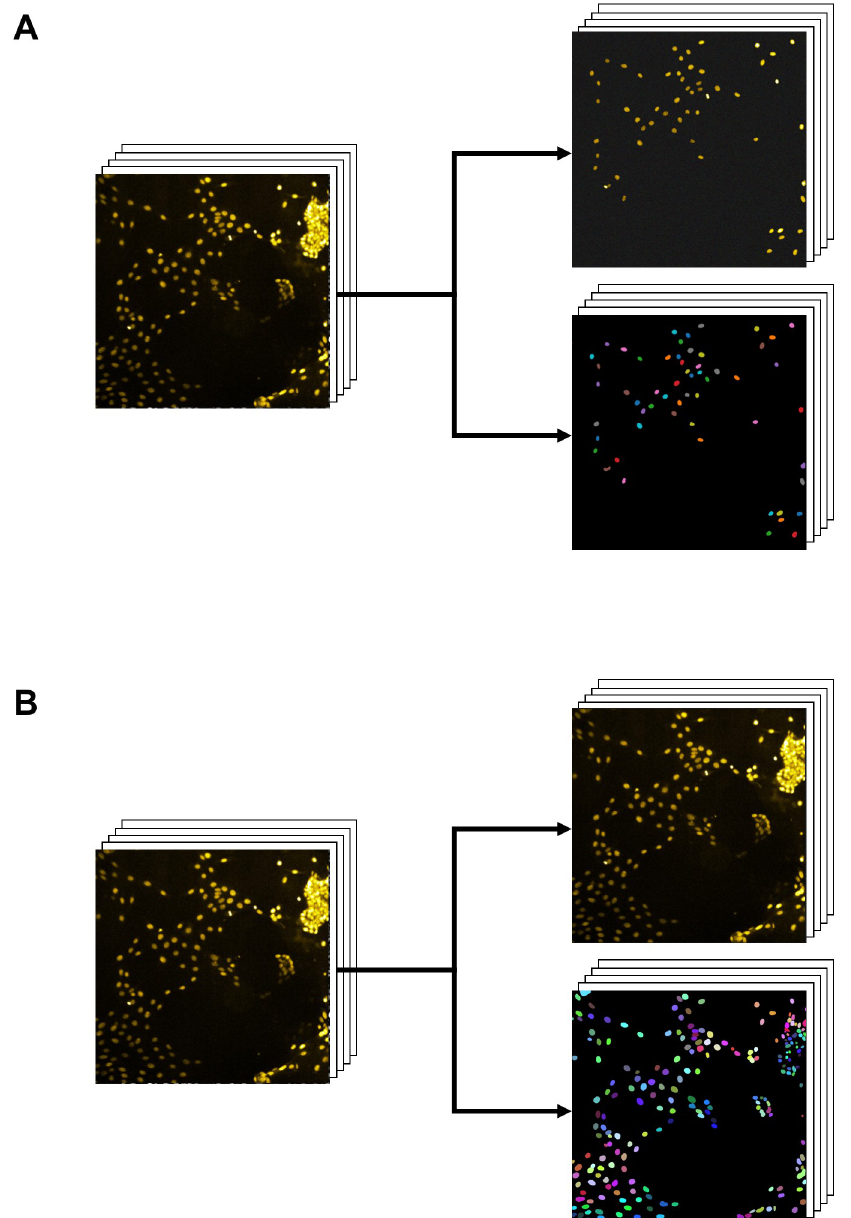
Fig 1. Automated and manual data annotation results. A: Automated nuclei annotation considers a fraction of manually annotated nuclei by coincidently ensuring high precision of labelled nuclei. B: Manual nuclei annotation considers all of the nuclei within the microscopy image. In both cases a training dataset of images and corresponding annotation masks is provided. Human mammary gland epithelial cells (primary cells) are used for demonstration